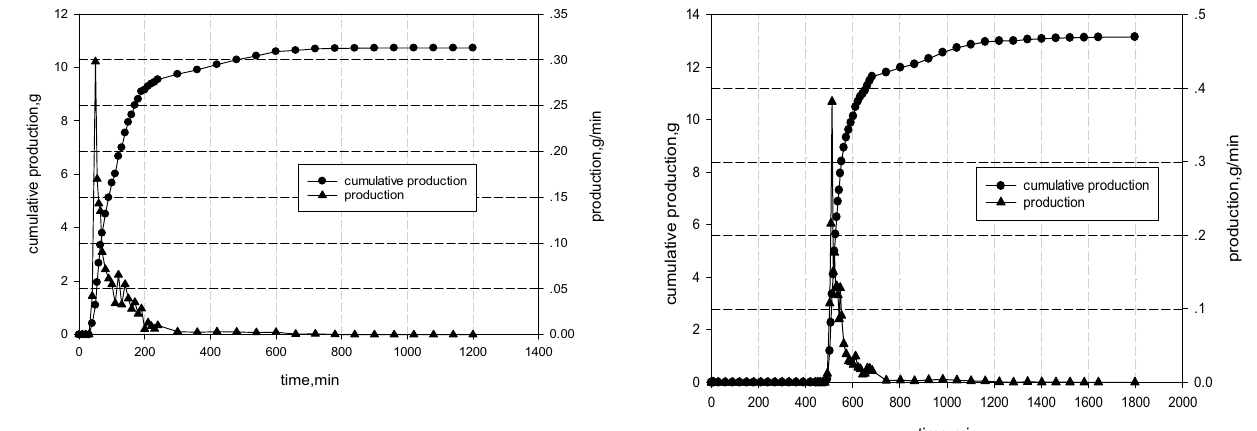
Fig. 2 Production rate and cumulative oil production curves in the CO 2 -flooding experiment